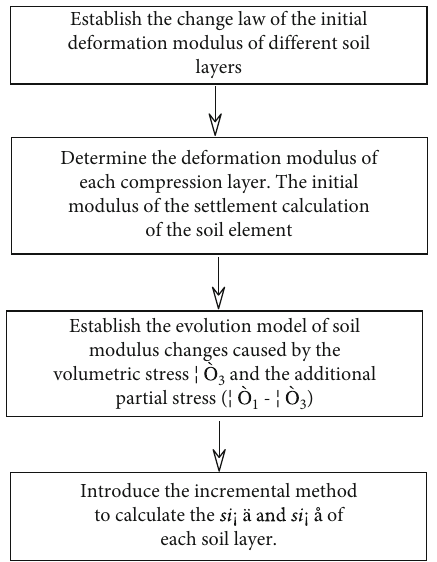
Figure 1: Calculation fl